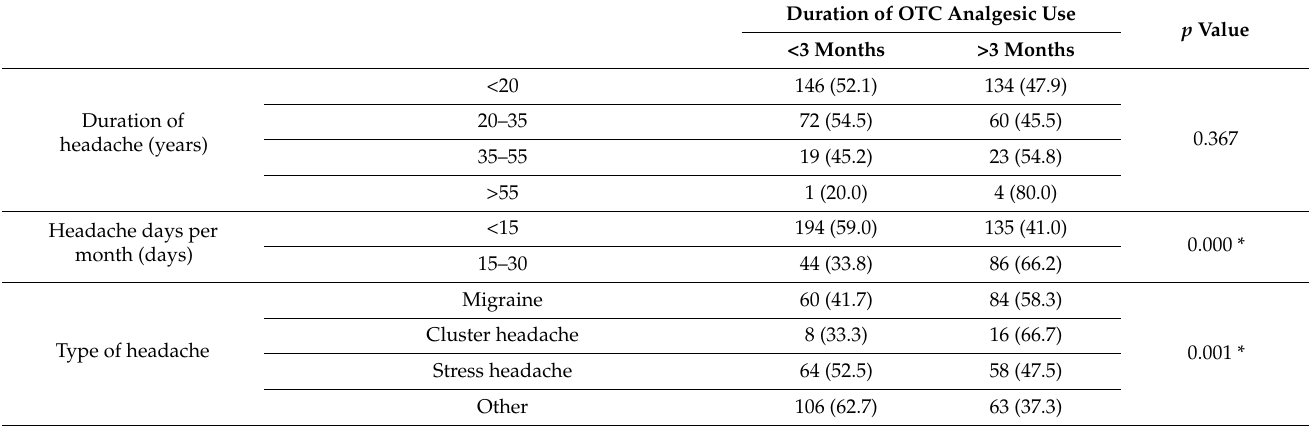
Table 3. The association between headache and OTC analgesic